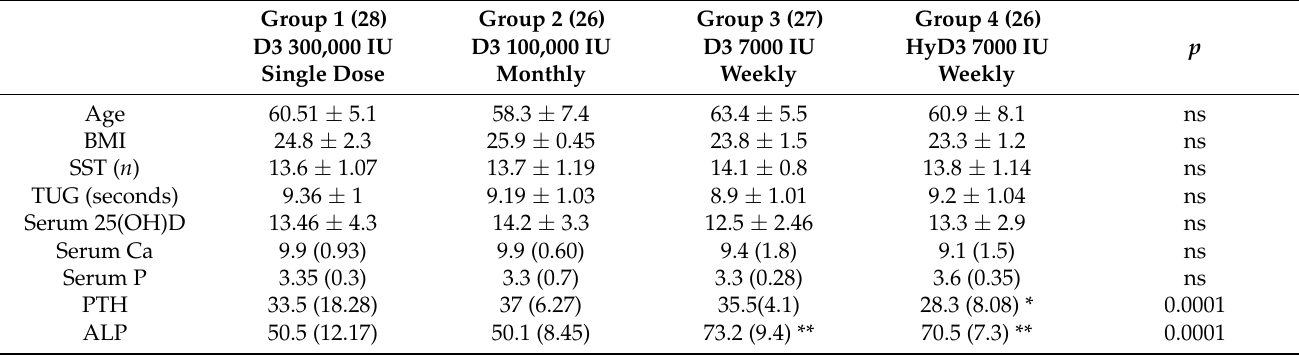
Table 1. Baseline characteristics of treatment